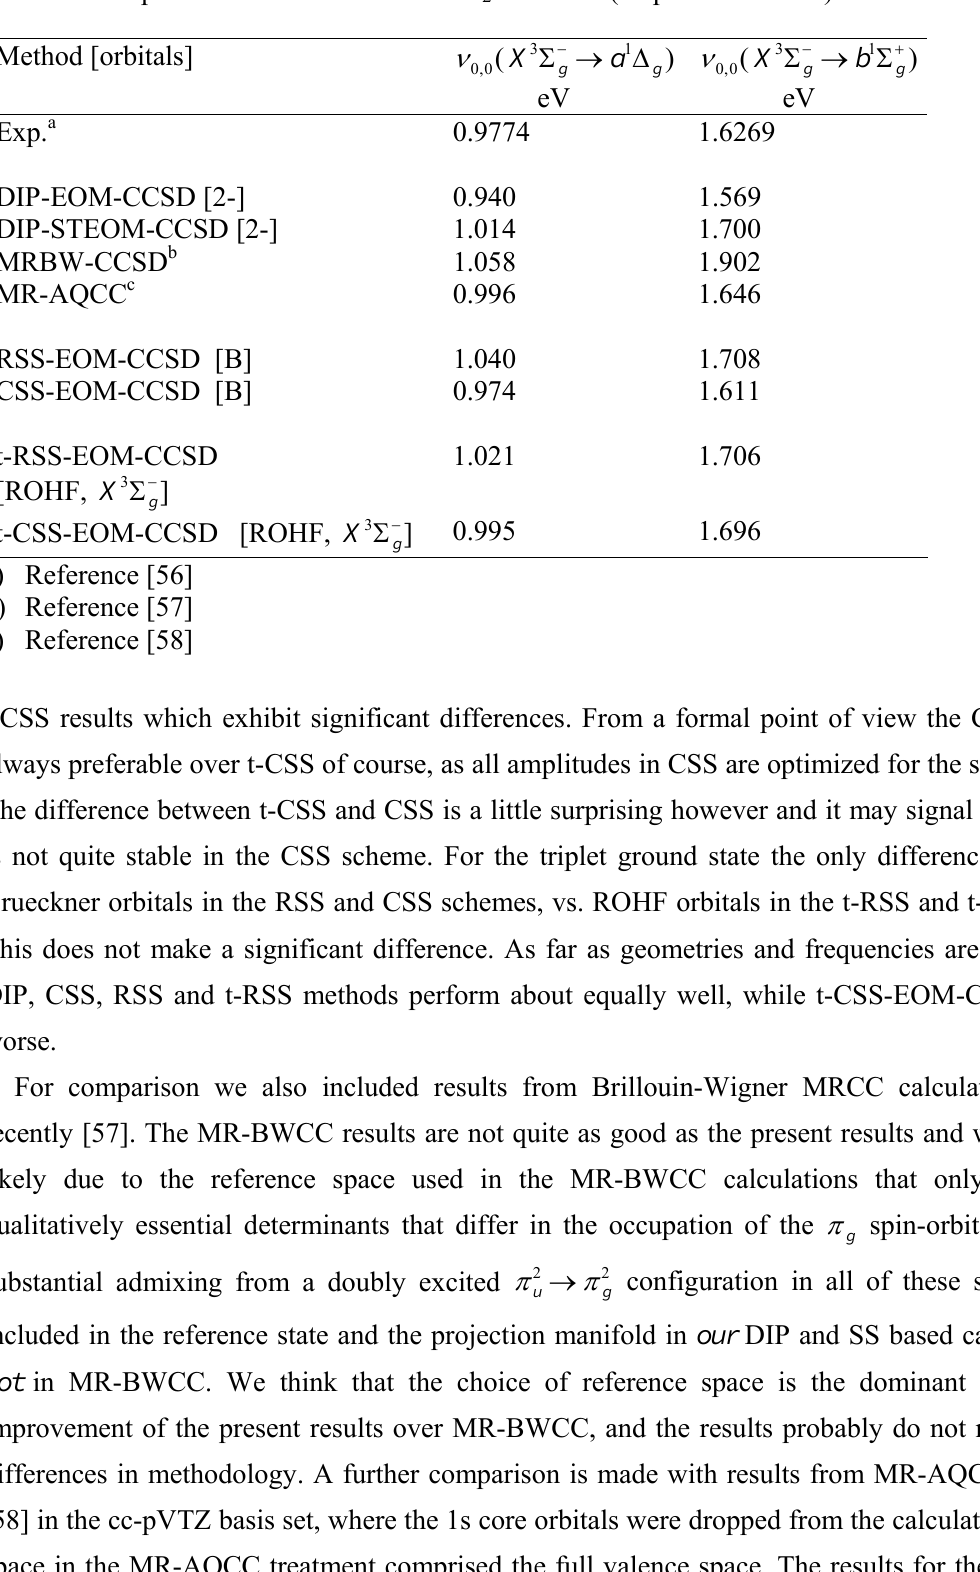
molecule (cc-pVTZ basis set) 2 0